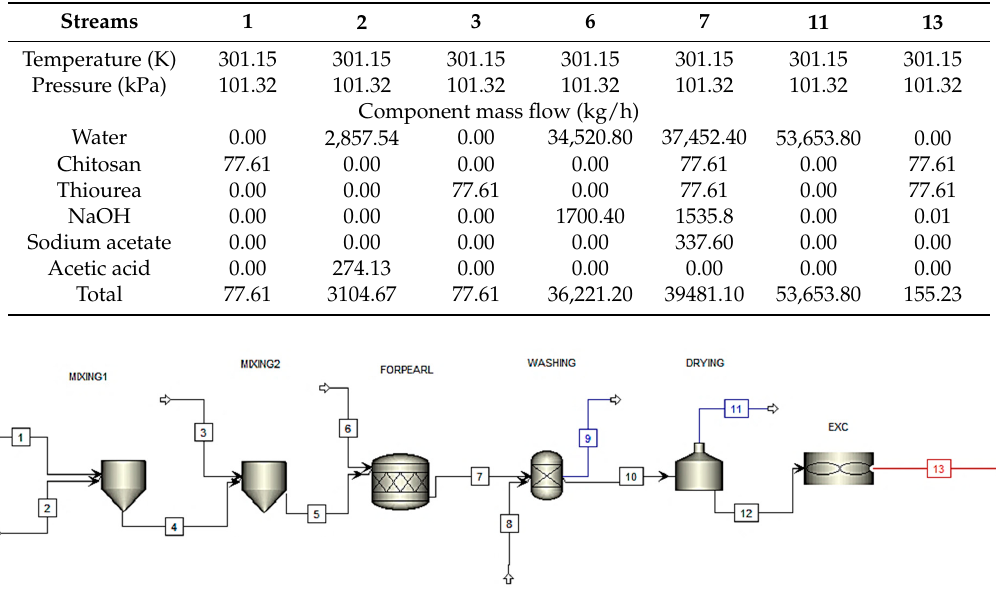
Figure 6. Process flowsheet of large-scale production of chitosan microbeads modified with thiourea Table 4. Main process streams for chitosan microbeads modified with thiourea